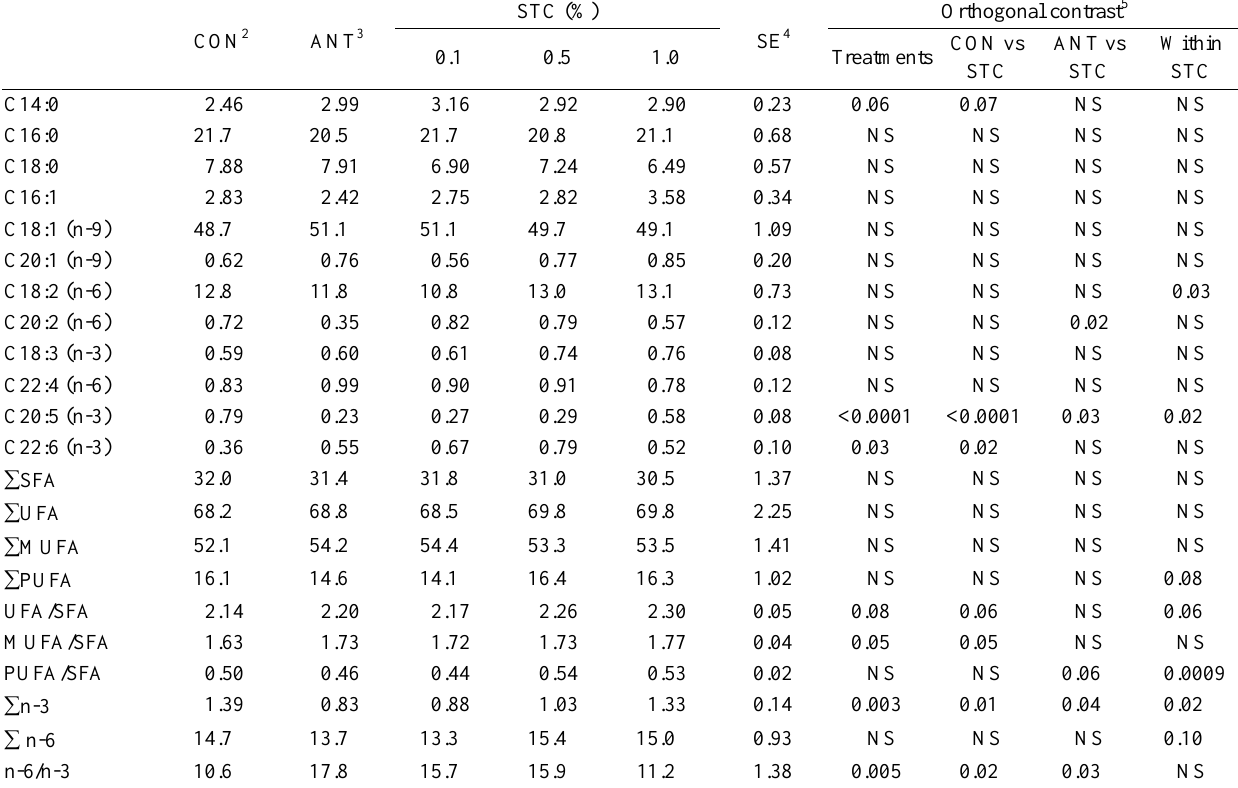
Table 7. Least squares means for the effect of dietary sea tangle ( L. japonica ) and charcoal supplementation on fatty acid composition (% of total fatty acids) of duck meat